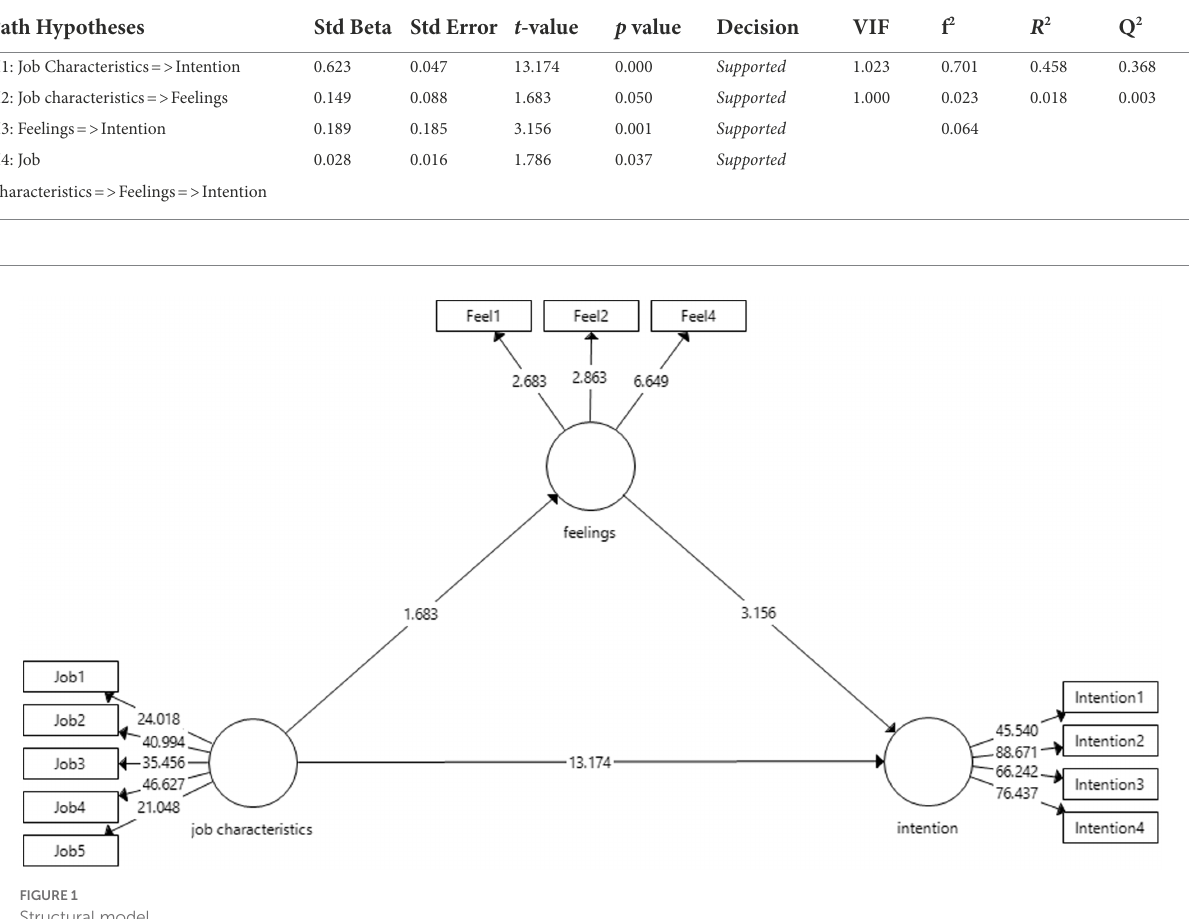
FIGURE 1 Structural